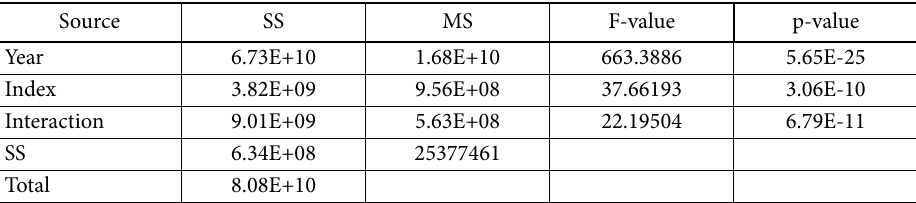
Table 2. Interaction test of indicator system Source